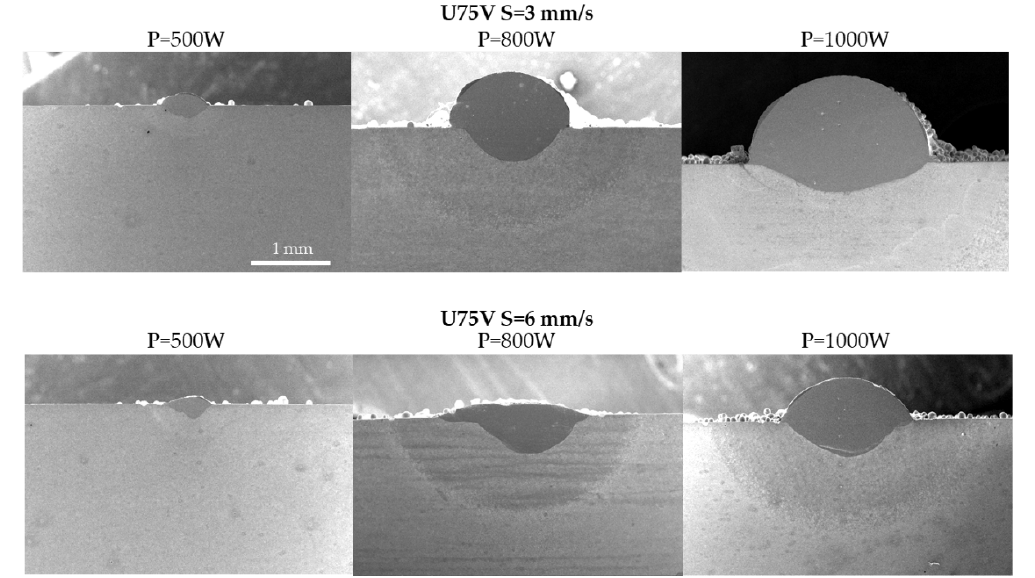
Figure 6. SEM images from cross-section of cladded rail steels at different conditions. For all cases, the laser cladded four times (four layers) on the substrates. Table 2. Geometry of cladded lines due to different laser powers and scanning